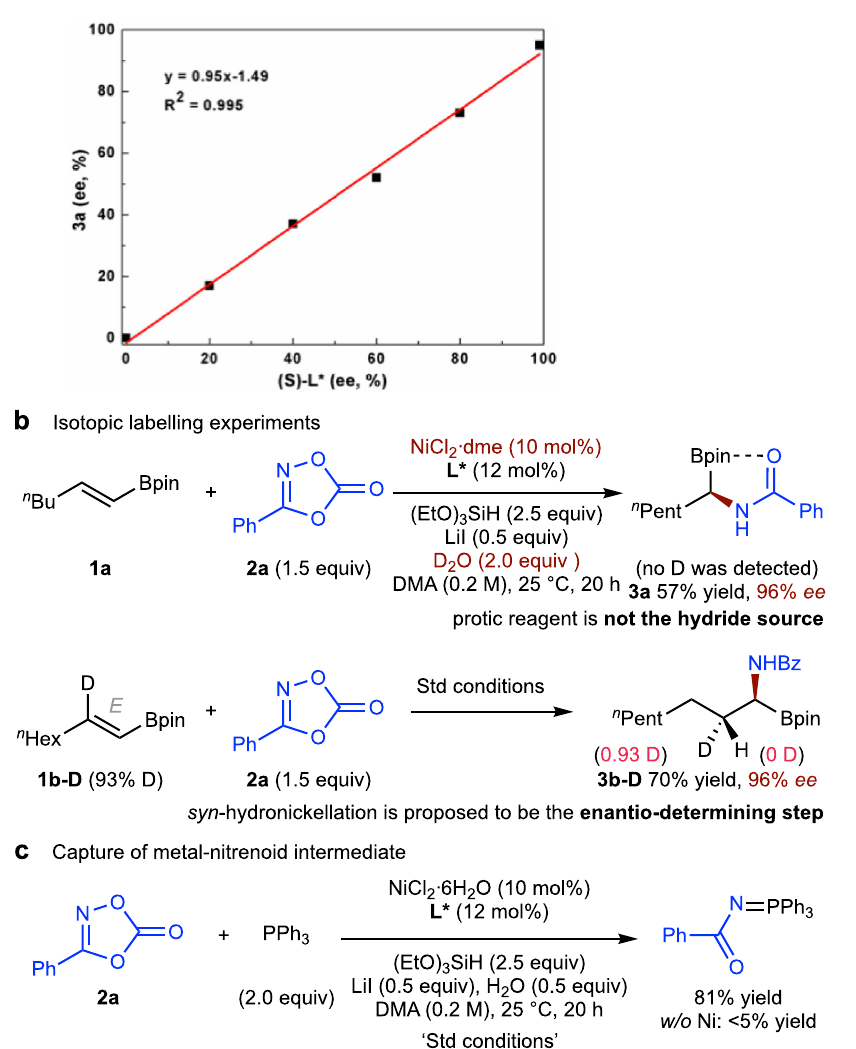
Fig. 6 | Preliminary mechanistic experiments. a Nonlinear effect. b Isotopic labelling experiments. c Capture of metal-nitrenoid